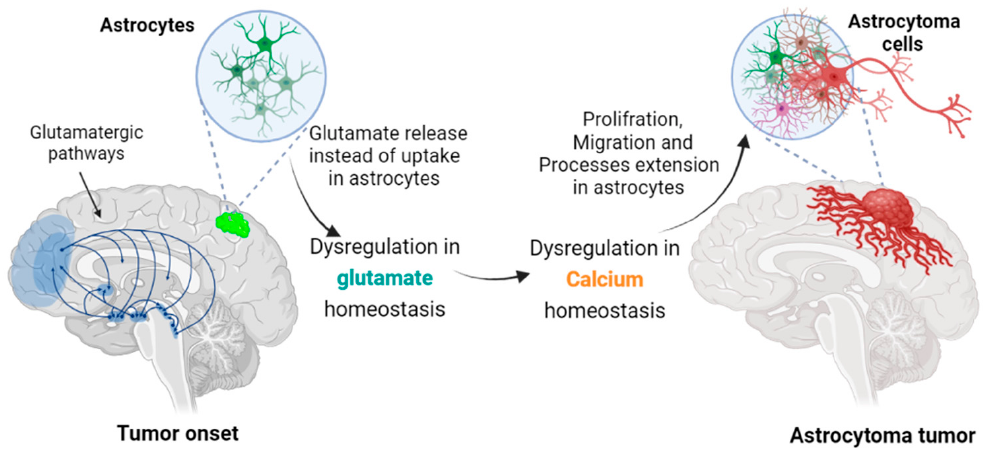
Figure 1. Transformation of astrocytes leading to astrocytoma cells. In grade II astrocytoma, the mutated astrocytes extend cellular projections that can infiltrate tissue distant from their soma location. Aberrant, excessive glutamate release at synapses is neurotoxic and could allow a tumor cell to spread in the interstitial space liberated by the retracting neurons. An associated glutamate-induced intracellular Ca 2+ rise in astrocytoma could also accelerate filopodiagenesis and cancer cell migration.